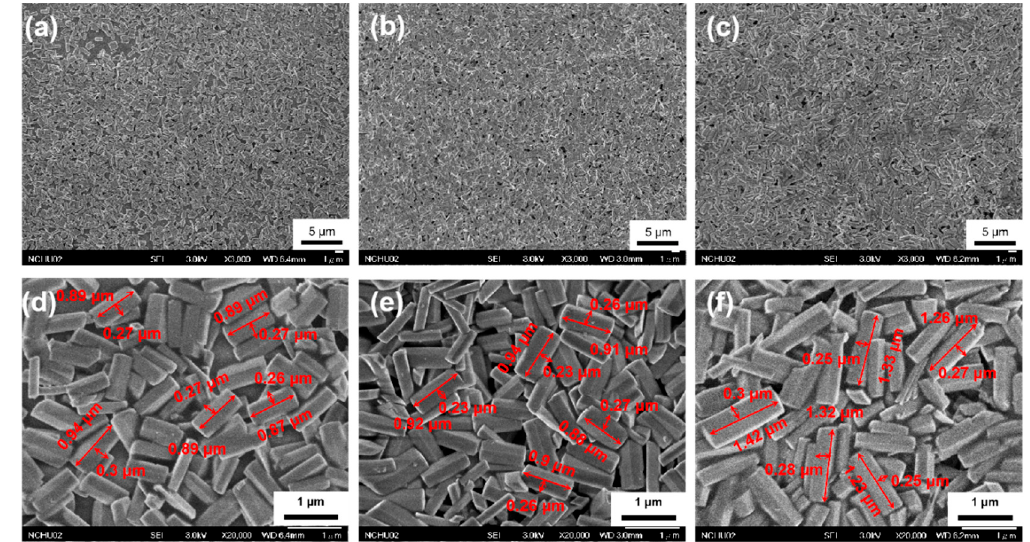
Figure 1. FE-SEM images of GaOOH prepared from Ga(NO 3 ) 3 at concentrations ranging from 0.025 M to 0.075 M: ( a ) 0.025 M; ( b ) 0.05 M; ( c ) 0.075 M. Their corresponding enlarged micrographs are shown in ( d – f ), respectively.